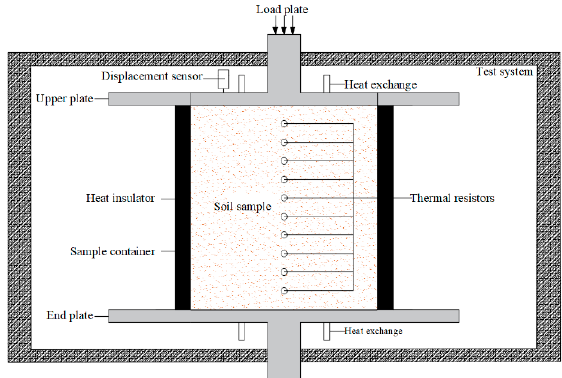
Figure 3. Schematic of the experimental apparatus.